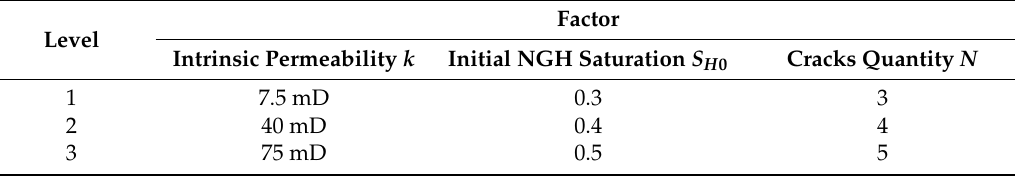
Table 4. The simulation experiments factor level table.